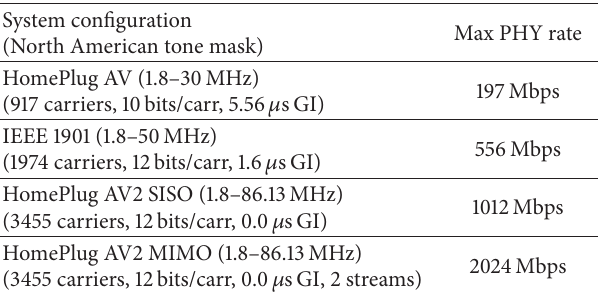
Table 3: Maximum PHY rate